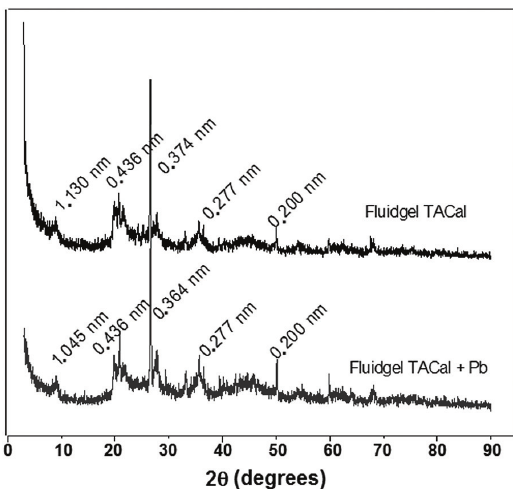
Figure 5. Diffractogram of Fluidgel TACal and Fluidgel TACal + Pb adsorbed.